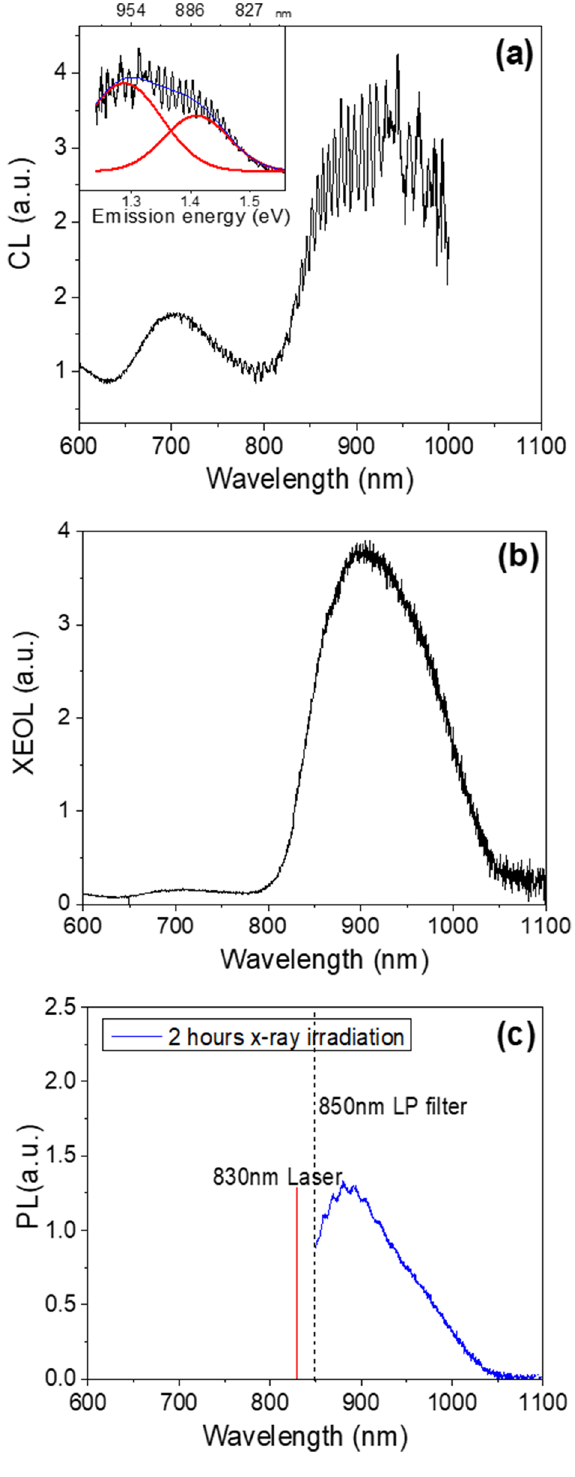
Figure 1. ( a ) Average cathodoluminescence (CL), ( b ) x-ray excited optical luminescence (XEOL), and ( c ) photoluminescence (PL) emission spectra of sample R47 at room temperature (~ 300 K). All the spectra are corrected for their respective system responses; however, no smoothing has been performed. The inset in ( a ) shows the deconvolution of the CL peak (~ 900 nm) into two peaks centered at ~ 880 nm (1.41 eV) and ~ 955 nm (1.30 eV). CL and XEOL emission spectra were measured after bleaching the sample for 48 h in a solar simulator. The PL emission spectrum was measured after bleaching followed by 2 h of x-ray irradiation. These images were generated using Originlab (Version: 8, Url: https ://www.origi